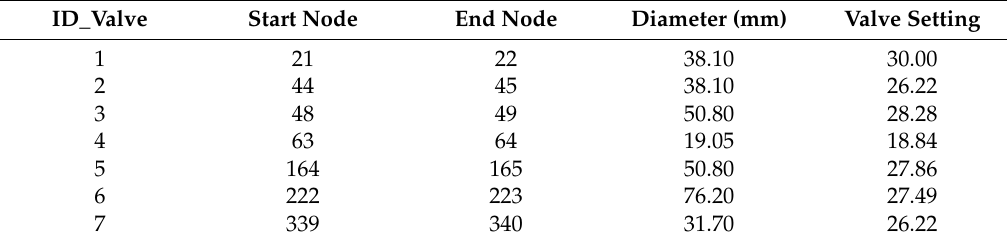
Table 7. New PRVs added to the FRM network.